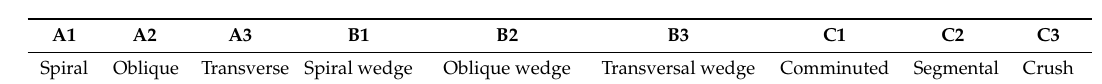
Table 1. AO classification of tibial shaft fractures.